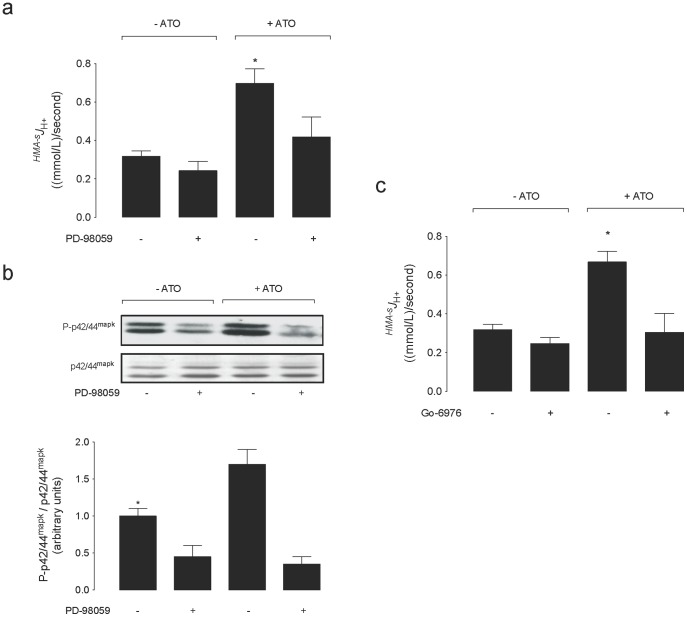
Involvement of p42/44mapk and PKC on ATO effect on HMA−s
J
H
+.(a) Transmembrane H+ flux rates sensitive to inhibition by 5-N,N-hexamethylene amiloride (HMA, 5 µmol/L) (HMA−s
J
H
+) in cells exposed for 48 hours to culture medium without (–ATO) or with (+ATO) 0.05 µmol/L arsenic trioxide (ATO) dissolved in water in the presence (–) or absence (+) of 30 µmol/L PD-98059. (b) Upper panel: Western blot for phosphorylated (P-p42/44mapk) and total p42/44mapk (p42/44mapk) in cells as in (a). ß-Actin was internal control. Lower panel: P-p42/44mapk/total p42/44mapk ratio densitometries derived from data in cells in the absence or presence of ATO, normalized to 1 in cells in the absence of ATO and PD-98059. (c) HMA−s
J
H
+ in cells as in (a) in the presence (–) or absence (+) of 10 µmol/L Gö6976. *P<0.05 versus all other values. Mean±S.E.M. (n = 9).